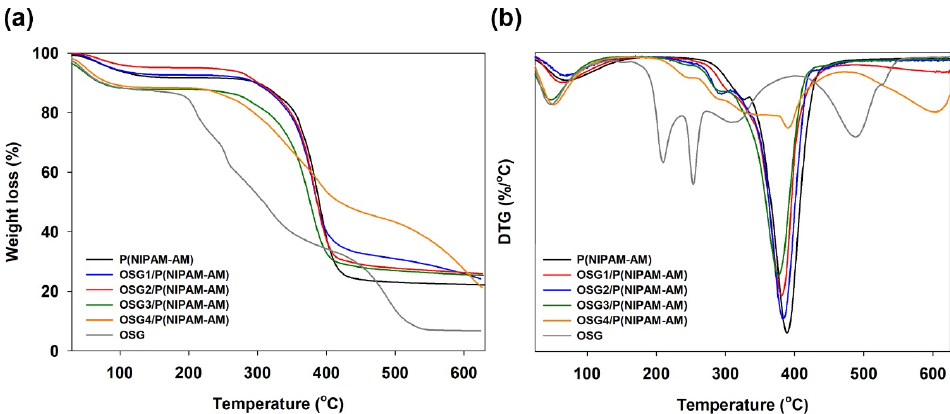
Figure 3. TGA ( a ) and DTG ( b ) curves from 25 to 600 °C of the OSG and prepared hydrogels.